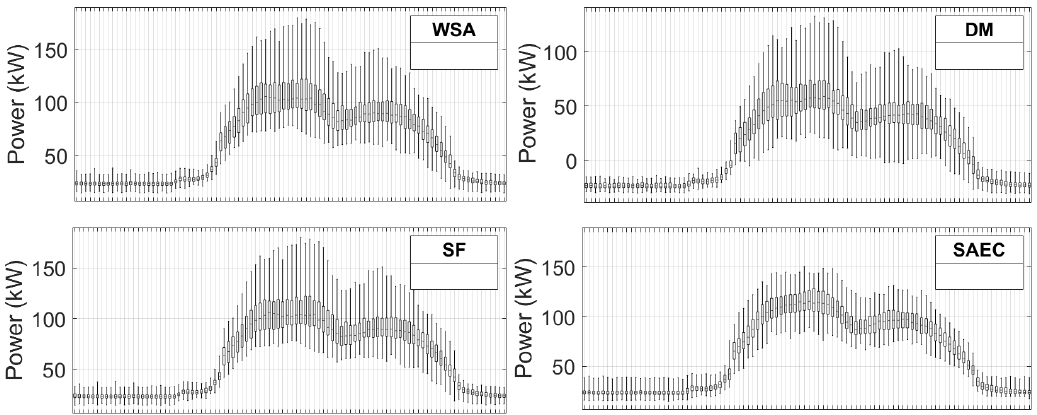
Figure 12. Electricity consumption pattern represented by box-plots for a working Wednesday; Building 5E of Universitat Politècnica de València.